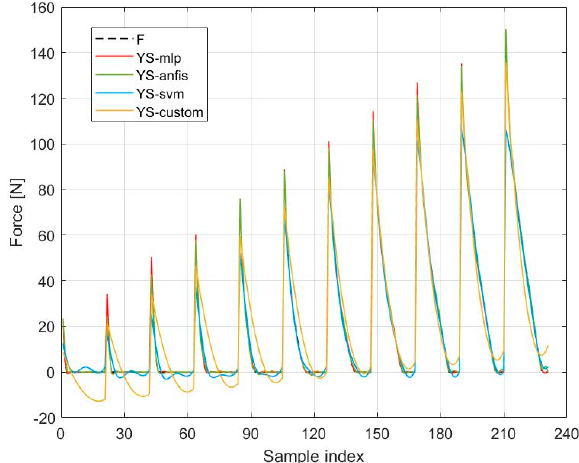
Figure 16. Comparison of the model outputs with the measured force for the DMSP-5